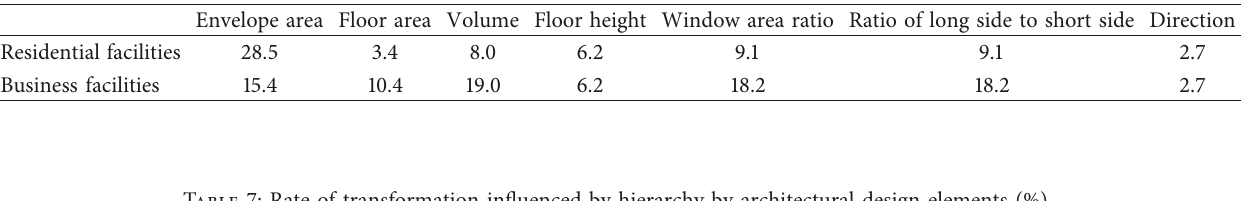
Figure 13: Energy consumption due to changes in tower incense and window area ratio Table 6: Rate of change of energy requirement by architectural design element (%).